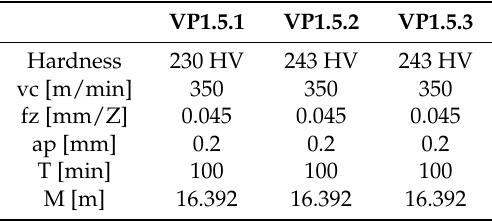
Table 3. Individual hardness of test blanks, cutting parameters, machining time T and length of cutting path M .